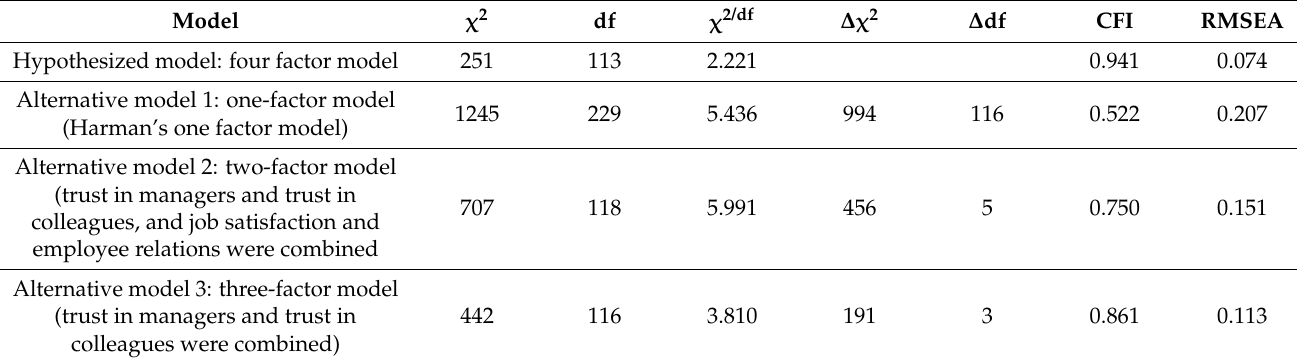
Table 1. Comparison of fit of the hypothesized model with alternative models.